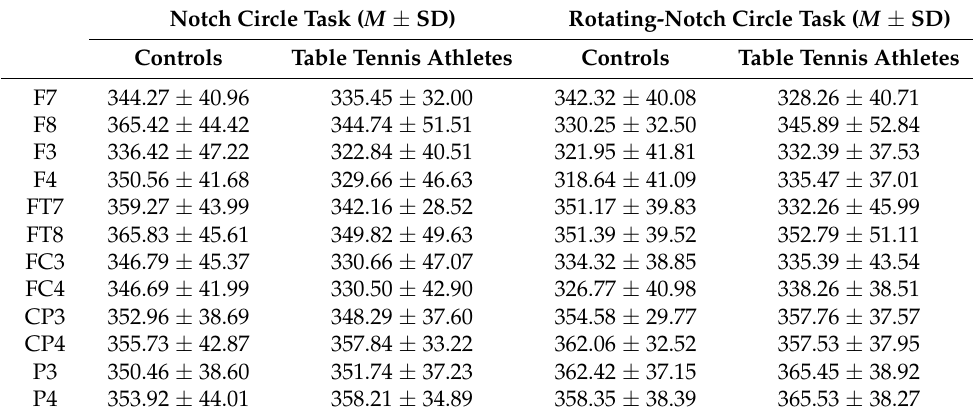
Table 4. Grand-average peak latency (ms) of the P3 component for correct responses across multiple electrode sites in the control and table tennis groups.